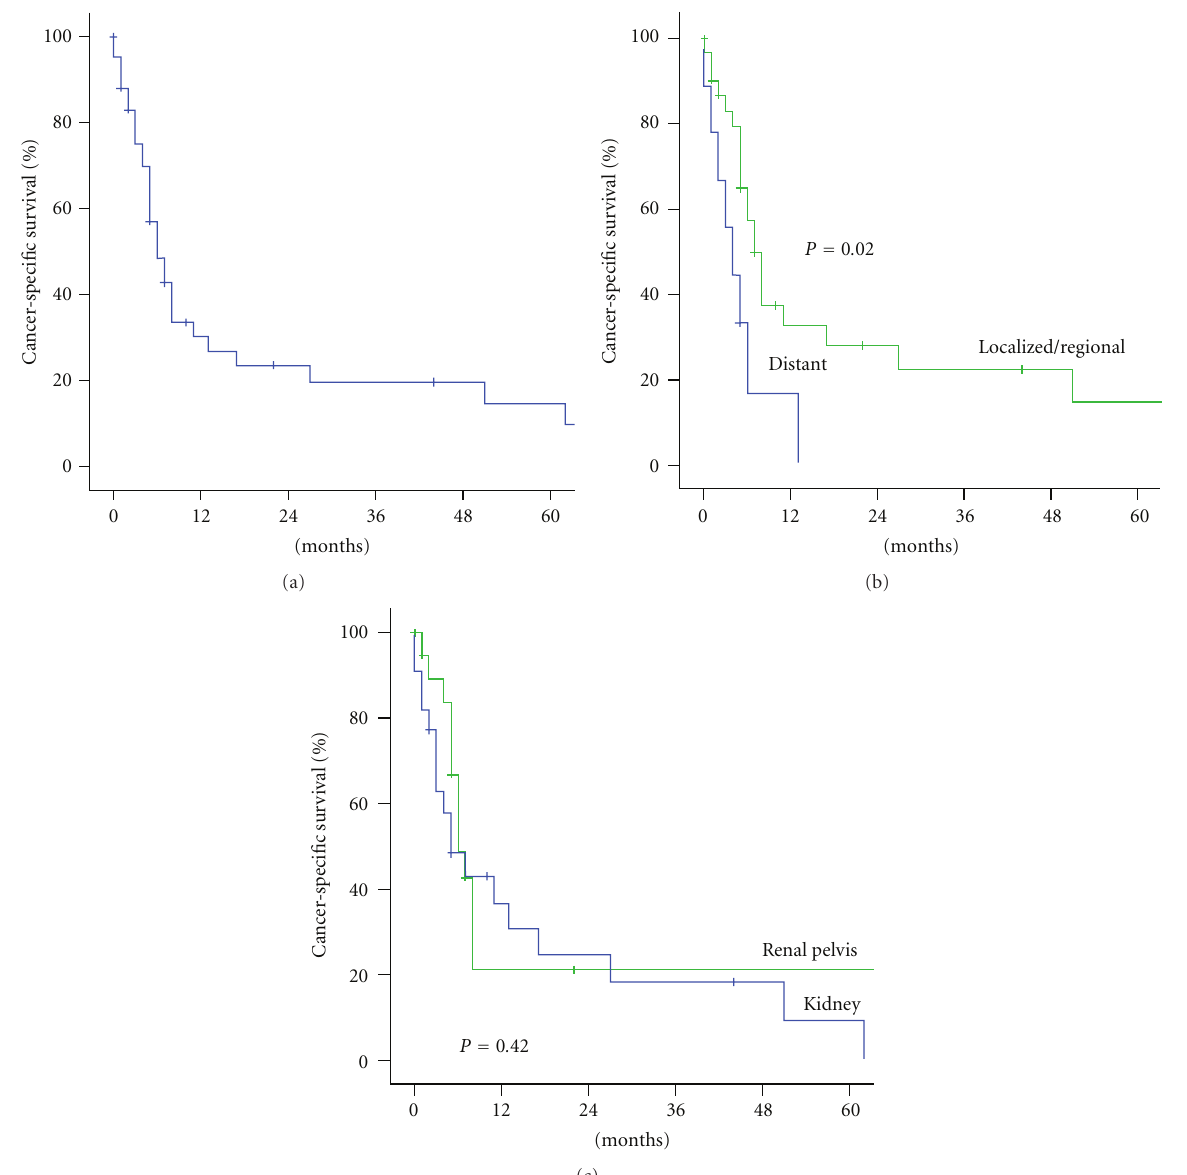
Figure 1: (a) Cancer-specific survival rate of patients with carcinosarcoma of the kidney and renal pelvis (CSKP). (b) Cancer-specific survival rate according to stage. (c) Cancer-specific survival rate according to tumor